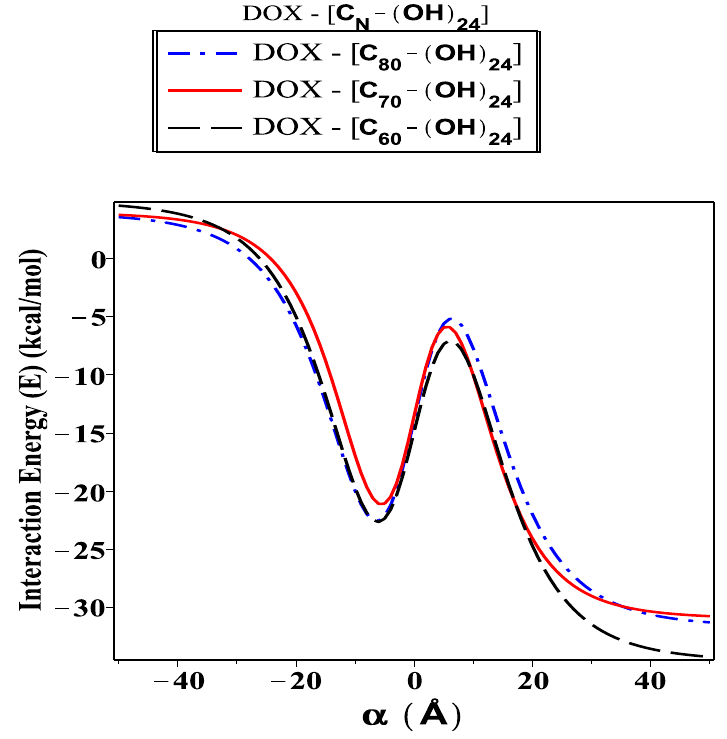
Figure 8. Interaction energy ( E ) arising from DOX molecule as tow-connected spheres, each as an arbitrary point interacting with fullerene derivatives (C N -[OH] 24